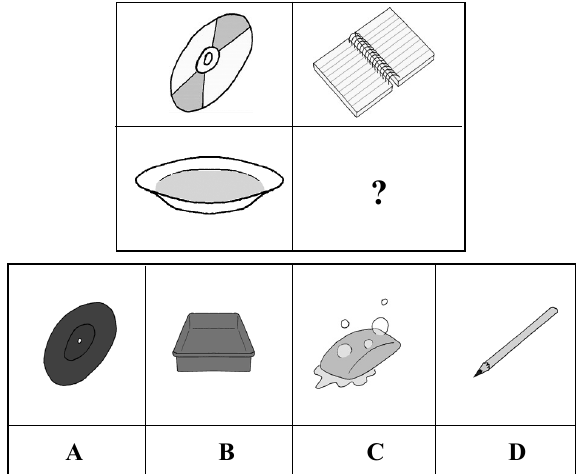
Figure 2 . Item of Cross Classification